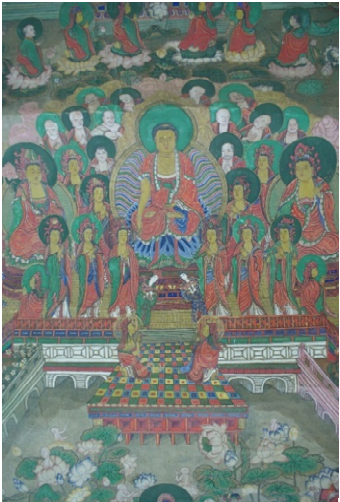
Figure 14. Detail of Three Gates in a Single Mind showing Amitābha Buddha in the central frame. Photograph by Choi Yeub.